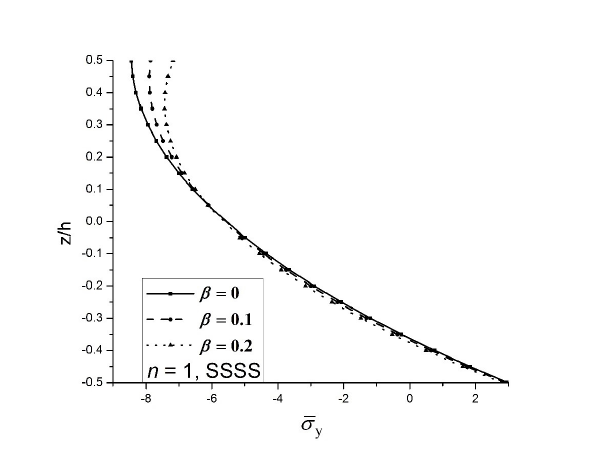
Figure 7: Effect of porosity on dimensionless axial stress of FGM-1 porous conoidal shell under uniform loading.